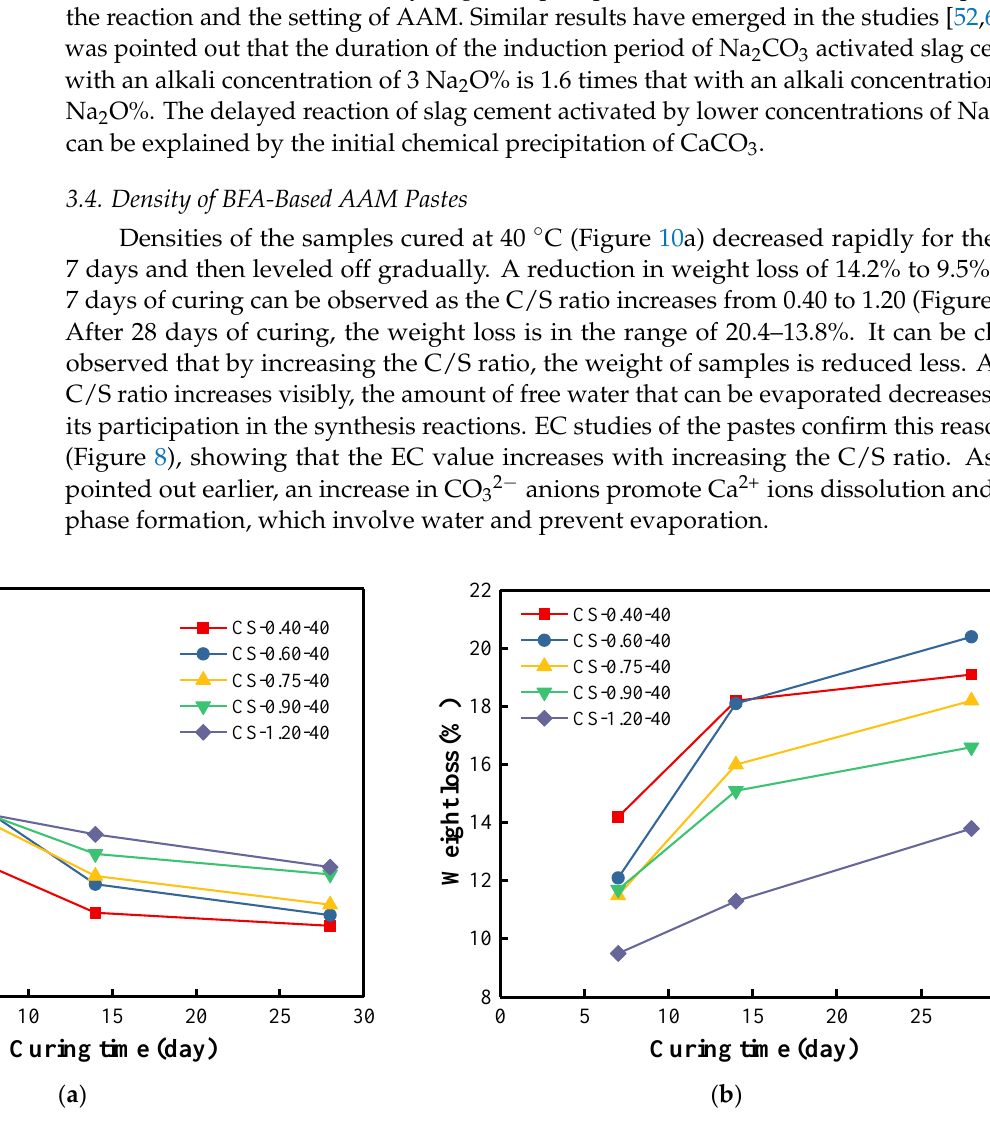
Figure 10. ( a ) Density of BFA-based AAM pastes cured at 40 °C for 28 days; ( b ) weight loss of samples in % during 28